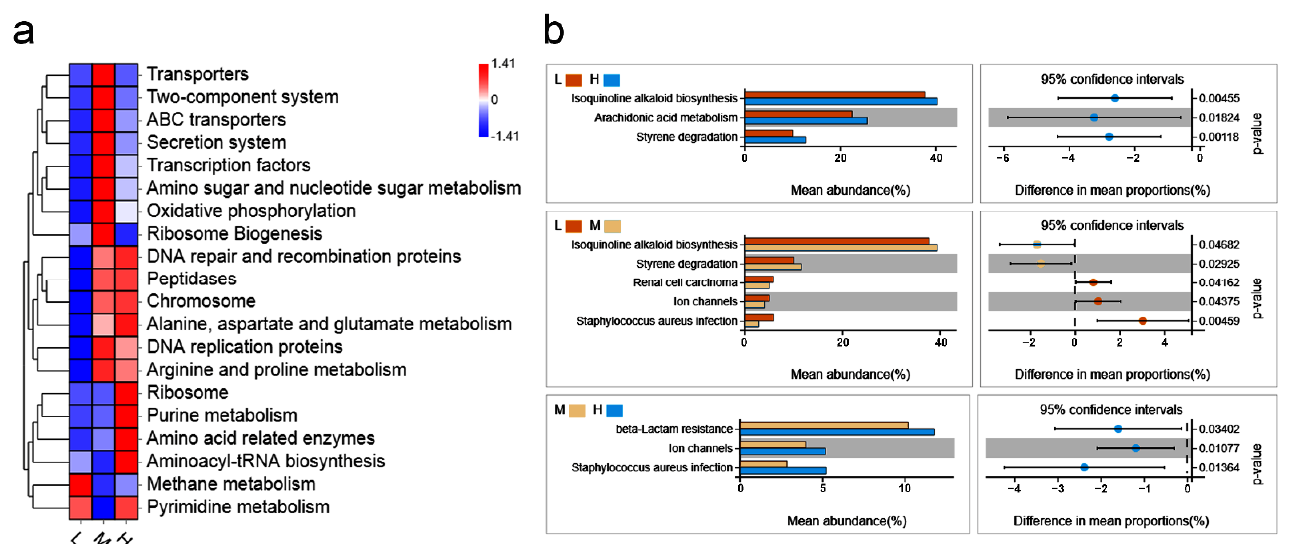
Figure 4. Functional analysis of microbes. PICRUSt software was used to analyze the function of microbes among different groups. ( a ) Heat map based on the abundance of the top 20 functional pathway. ( b ) Significance analysis of functional pathway based on the Welch’s t-test.